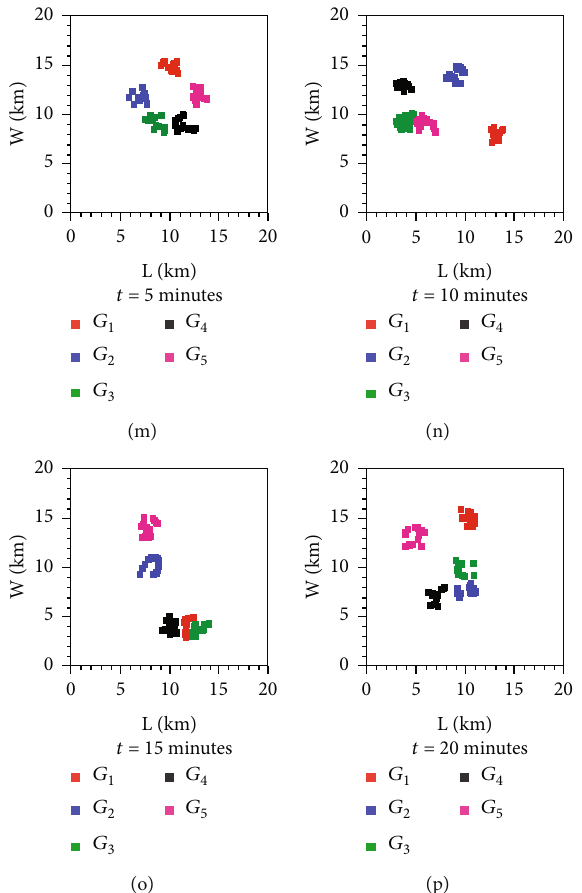
Figure 12: Trajectory comparison for the four mobility models from t = 5 minutes to t = 20